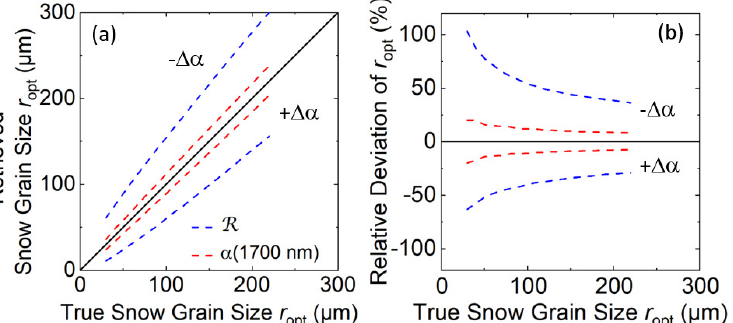
Figure 9. Effect of the SMART measurement uncertainty on the accuracy of the retrieved r opt derived from a model-based sensitivity study for SZA = 80°. ( a ) Correlation of retrieved and true (input) r opt , ( b ) relative deviation in % depending on true r opt . Results are shown for the α (1700nm)-based and R -based retrieval using